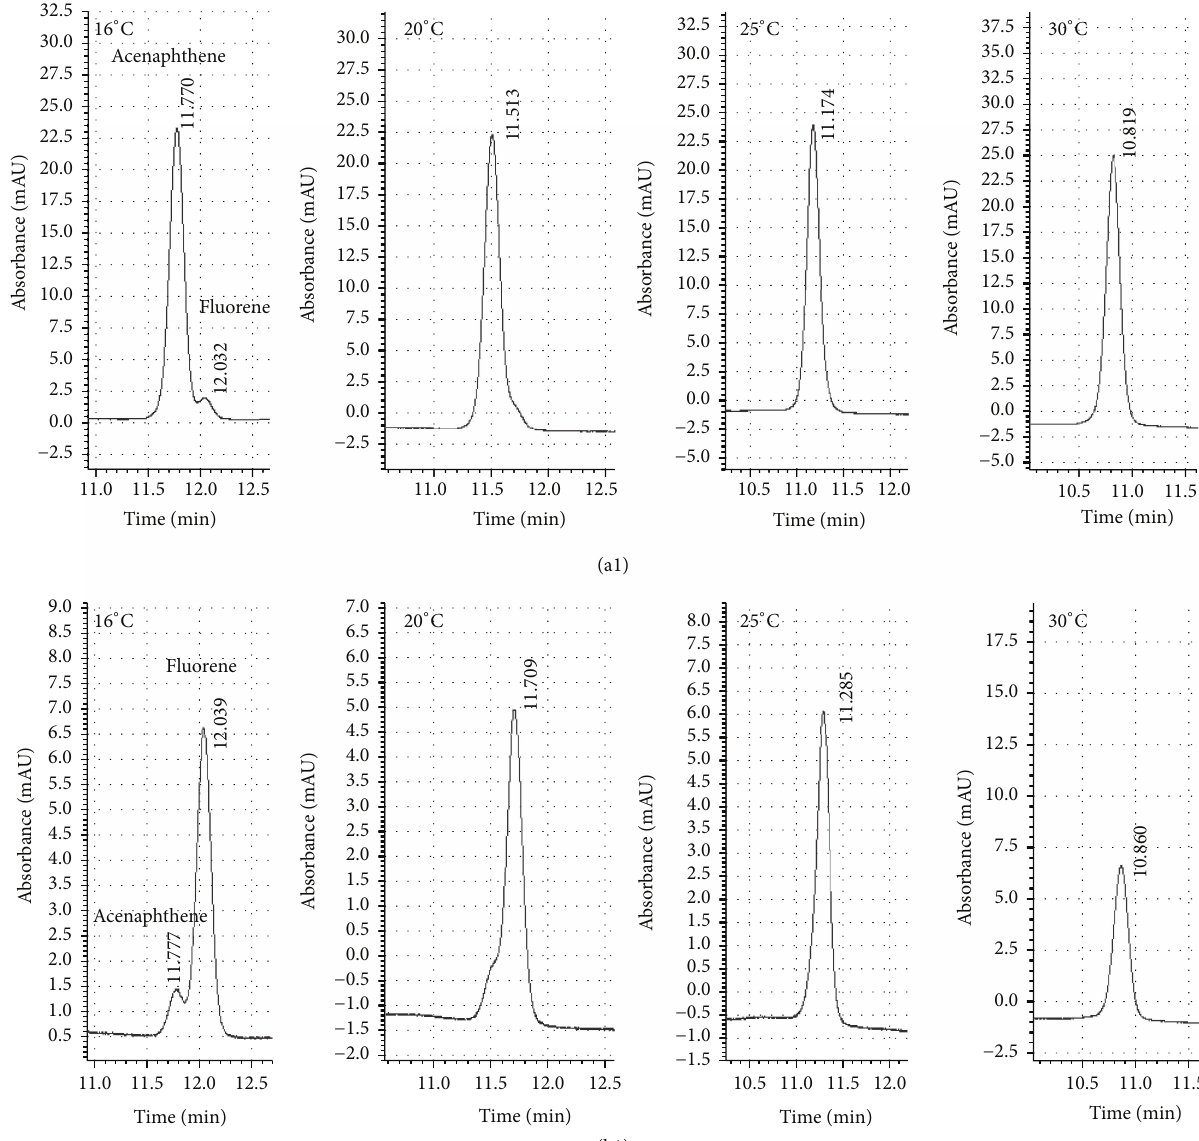
Figure 3: Effect of the temperature on the separation of fluorene and acenaphthene using the Spherisorb column; (a1) at 227 nm; (b1) at 261